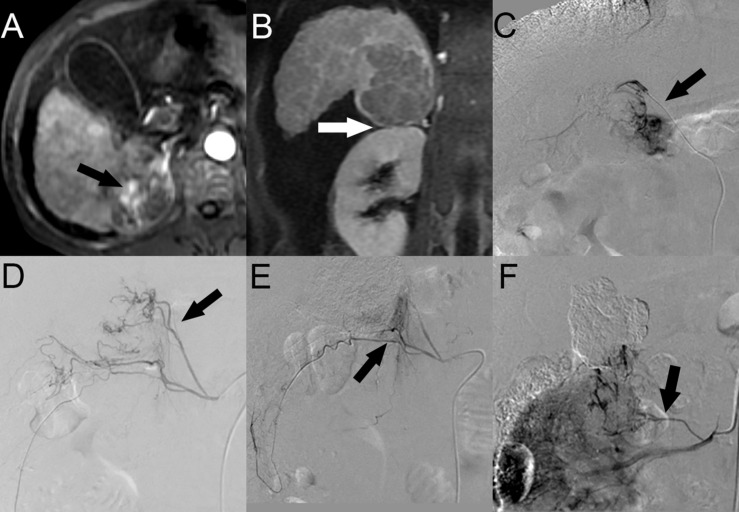
HCC with SARPS invasion in a 49-year-old man. (A) Contrast-enhanced arterial phase MR image showed a 5.4-cm-sized enhanced tumor (black arrow) in segment 7 of the right lobe of the liver in the axial plane. (B) Portal phase MR image showed clear tumor invasion of the SARPS in the coronal plane (white arrow). (C) Angiographic image at the first TACE session revealed that the tumor was supplied by the posterior branch of the RIPA (black arrow). (D) Angiographic image at the second recurrence revealed that the EHCs were supplied by the inferior branch of the RAA (black arrow). (E) After the inferior branch of the RAA was successfully chemoembolized, the angiogram showed that the superior branch of the RRCA was also involved in the tumor blood supply (black arrow). (F) Angiographic image at the fourth recurrence revealed that the tumor was supplied by the new inferior branch of the RAA (black arrow). Abbreviations: HCC, hepatocellular carcinoma; SARPS, superior aspect of the right perirenal space; RIPA, right inferior phrenic artery; RRCA, right renal capsular artery; RAA, right adrenal artery; and EHC, extrahepatic collateral vessel.